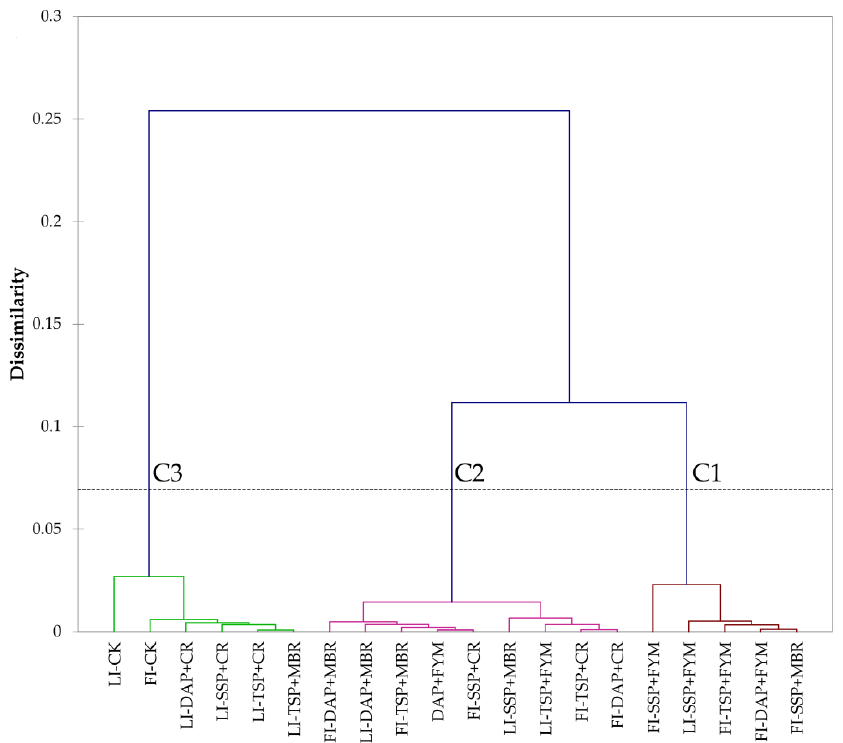
Figure 4. Cluster analysis of 10 investigated treatments applied on wheat grown under different irrigation regimes. C1, C2, and C3 are clusters 1, 2, and 3, respectively. FI = full irrigation; LI = limited irrigation; FYM = farmyard manure; MBR = mung bean residue; CR = canola residue; TSP = triple super phosphate; SSP = single super phosphate; and DAP = di-ammonium phosphate.